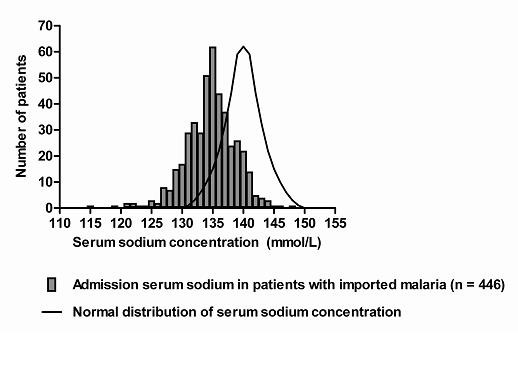
Distribution of serum sodium in patients with imported malaria.